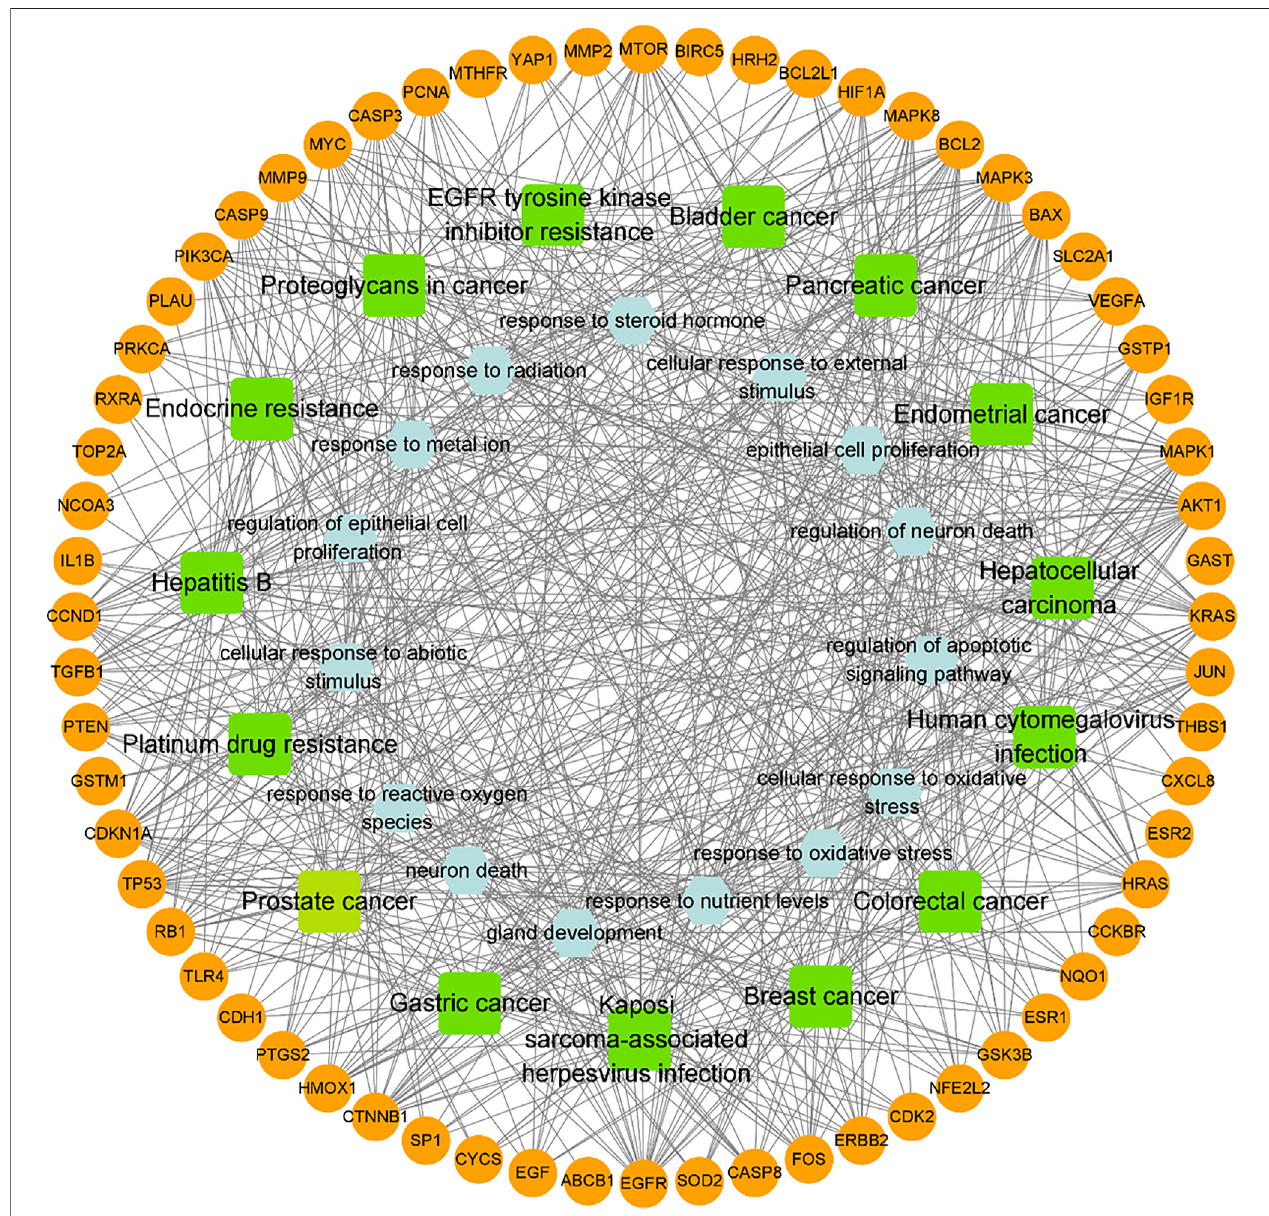
FIGURE 4 | Network of the target-biological process pathway. The orange circle represents the target of the compound acting on the disease, green square represents the co-associated pathway, and light blue hexagon represents the top 15 biological process-related terms.